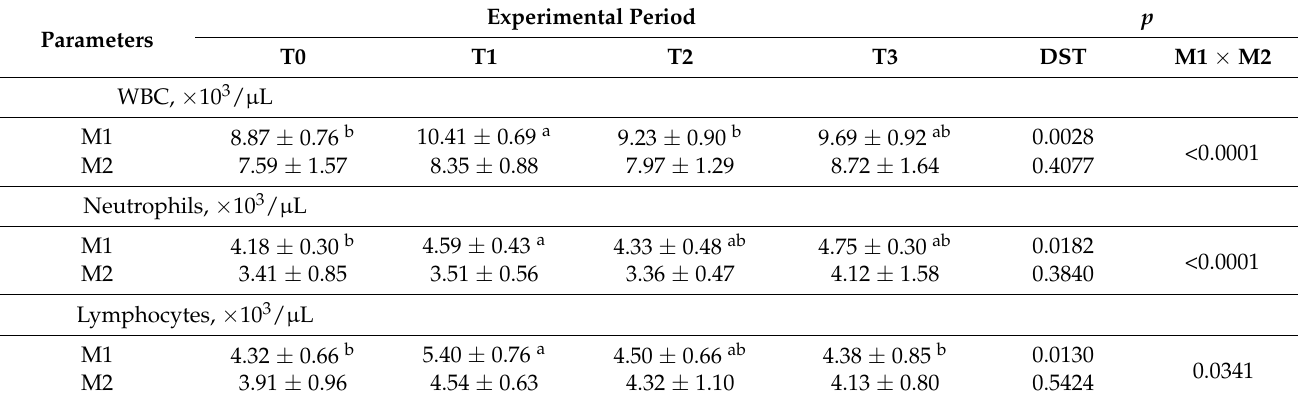
Table 4. Total WBC and neutrophil and lymphocyte counts measured in the dressage simulation tests used to evaluate a 6-week training protocol for Lusitano